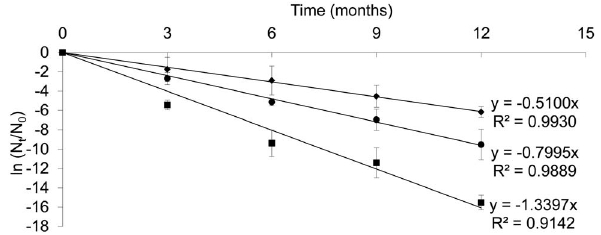
Figure 1. Effect of storage conditions on bacterial stability within the laboratory powder. Plot of ln(N t /N 0 ) for powders N obtained with the laboratory assay against time and temperature ) and 30 u C ( & ) (Mean of three values), according to the 20 u C ( ¤ ), 25 u C ( current regulation (ICH Guideline Q1A). doi:10.1371/journal.pone.0079041.g001 PLOS ONE |